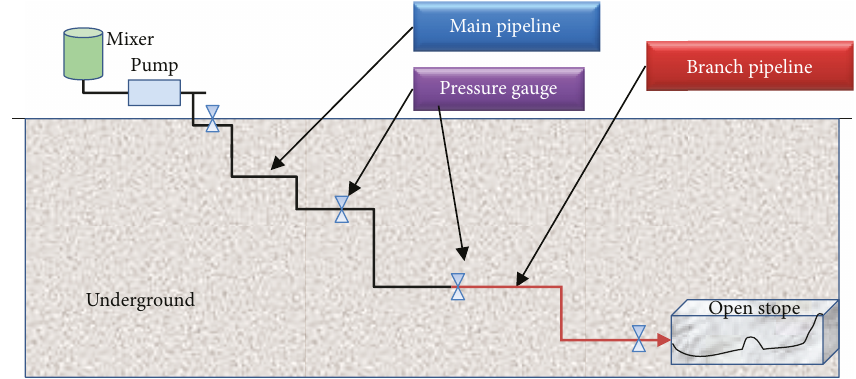
Figure 6: Sketch map of the PG back fi ll industrial test.